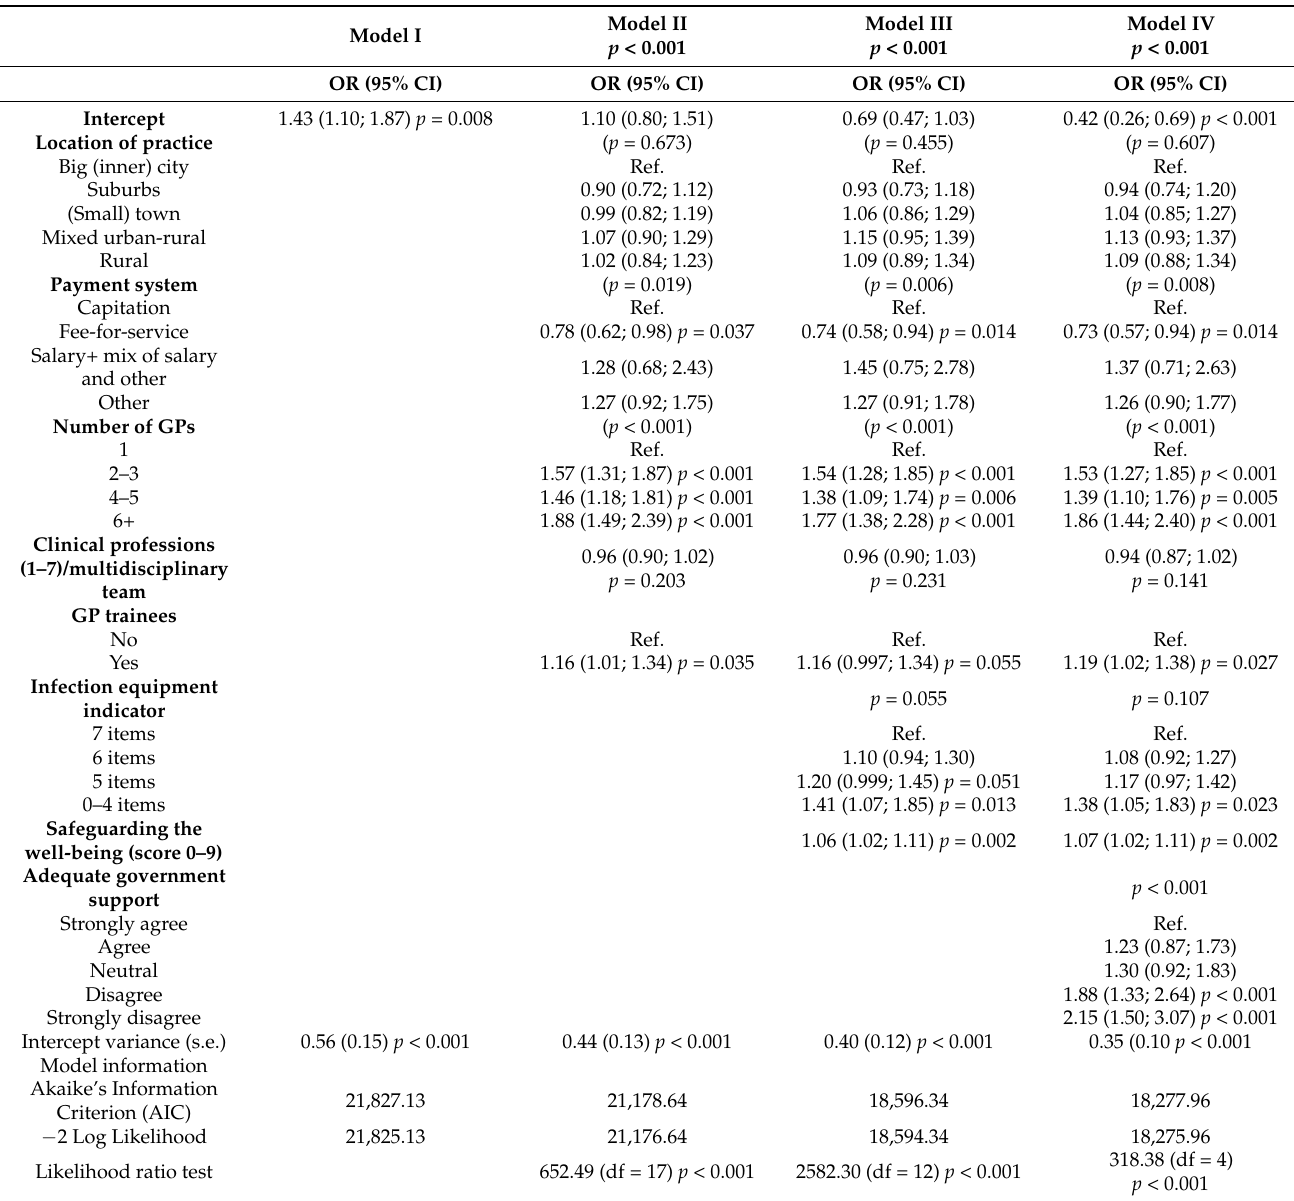
Table 4. Results of mixed effects logistic regression analysis of potential predictors for an experience of limitations related to the building or the practice